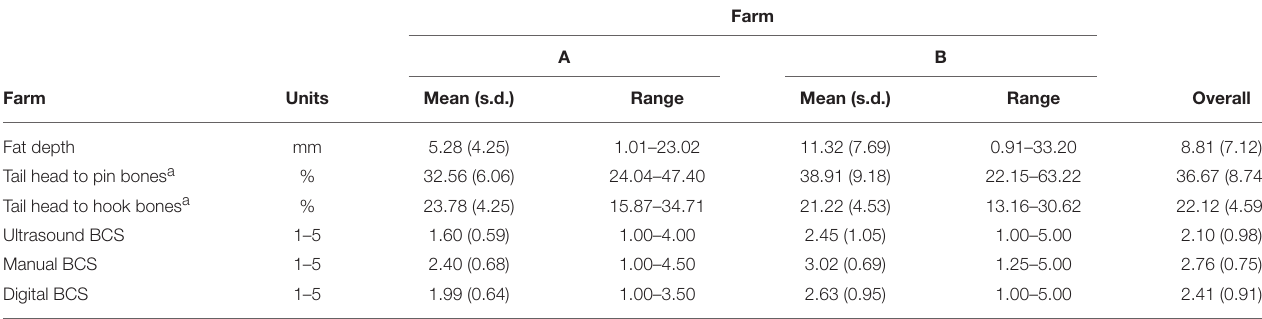
TABLE 1 | Mean (s.d.) body fat depth, tail head to pin and hook bone widths, ultrasound, manual, and digital body condition scores at Farm A and B and across farms.